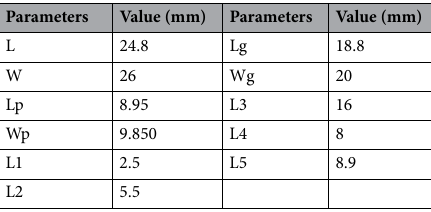
Table 1. DG antenna design